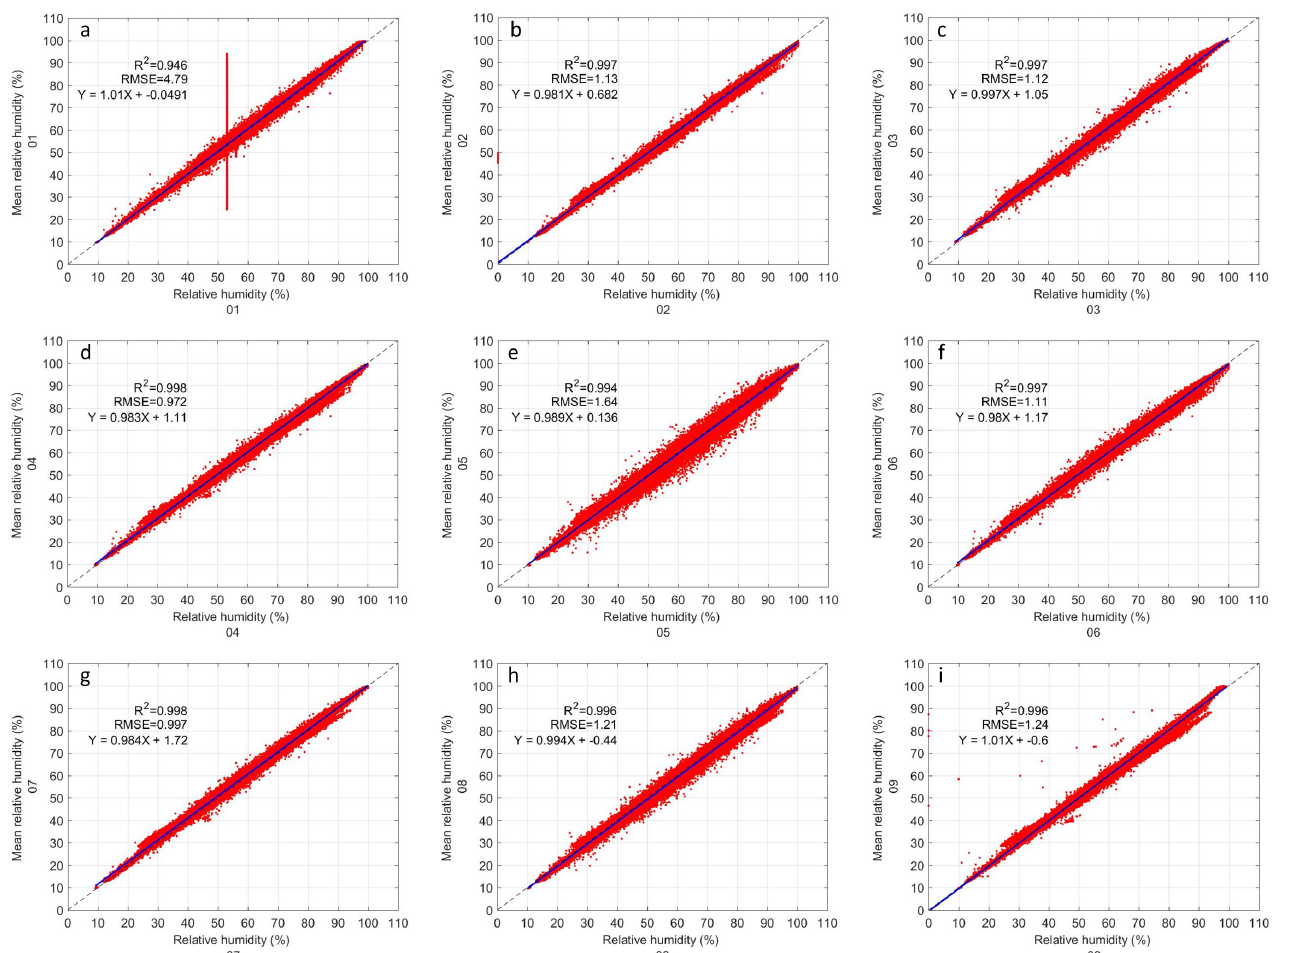
Figure 5. Same as Figure 3 but for relative